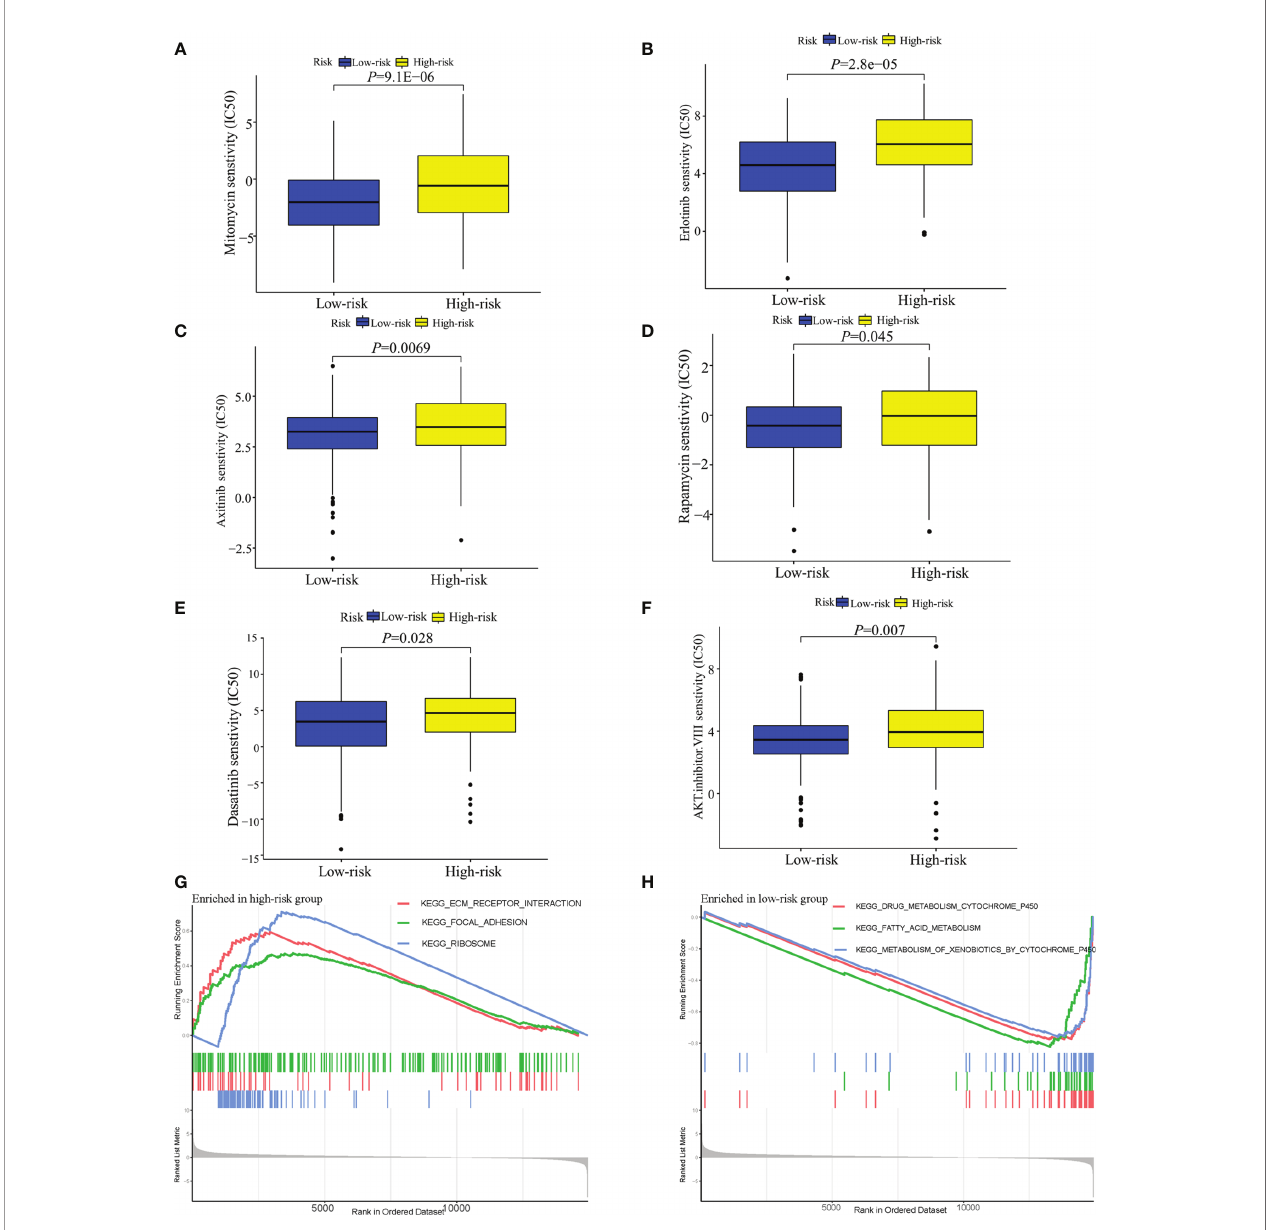
FIGURE 7 | Analysis of the sensitivity toward drug therapy in high-risk and low-risk groups. (A – F) Sensitivity of high-risk and low-risk groups of TCGA-LIHC cohort to drug therapy. (G) The top three upregulated pathways in the high-risk group of TCGA-LIHC cohort. (H) the top three downregulated pathways in the low-risk group of TCGA-LIHC